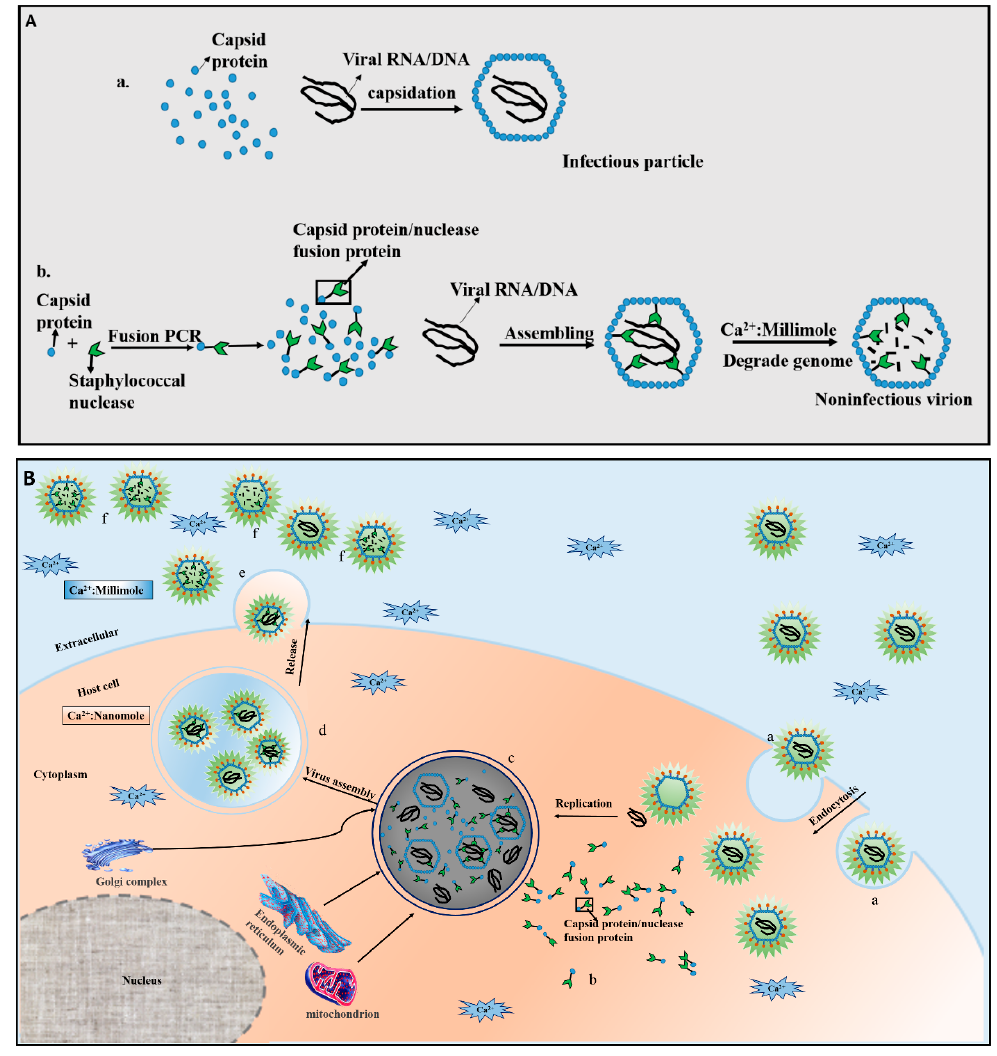
Figure 1. The main mechanism of capsid-targeted viral inactivation (CTVI). ( A ) Comparison of viral genome encapsidation in a normal virus and a virus containing a capsid–enzyme fusion protein [3]. a . Normal assembly of viruses, whereby nucleic acid is enveloped by capsid proteins to form the nucleocapsid; b . The assembly process of the virus with a fusion protein composed of a capsid protein and a degradative enzyme (e.g., staphylococcal nuclease (SN)) that is calcium ion (Ca 2+ ) dependent. The fusion protein is incorporated into the internal virion during viral assembly, where is has direct access to nucleic acid. When the Ca 2+ concentration reaches the millimolar range, the enzyme is activated and digests the viral RNA/DNA; ( B ) A schematic representation of the CTVI mechanism. Infection of a cell by a virus stably expressing a fusion protein mainly includes the following steps: a . The virus enters the host cell through the endocytosis pathway; b . the fusion protein is stably expressed; c . using material supplied by the host cell, the fusion protein is incorporated into the viral structure during viral assembly; d . the virus is assembled and modified to form a mature virion within closed vesicles in the cytoplasm, but the nuclease in the virion is inactive due to the intracellular nanomolar Ca 2+ concentration; e . the virus is released into the extracellular environment; f . the nuclease incorporated into the progeny virion is active in the extracellular millimolar Ca 2+ concentration, where it can degrade the viral nucleic